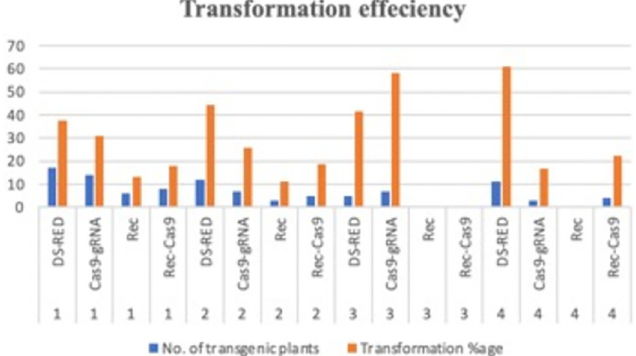
Fig 7. Transformation effeciency: Transformation effeciency depicted in four distinct batches of all the four plasmids transformed (pKGWRR, pHSE-401, pG-Rec and pCas-Rec). Transformation percentage per batch is calculated on the basis of positively transformed